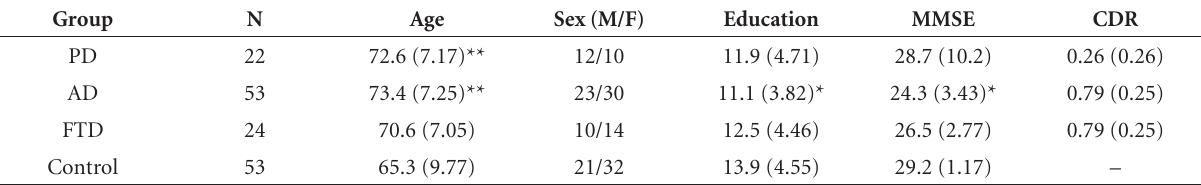
Table 1. Demographic and clinical profile of the